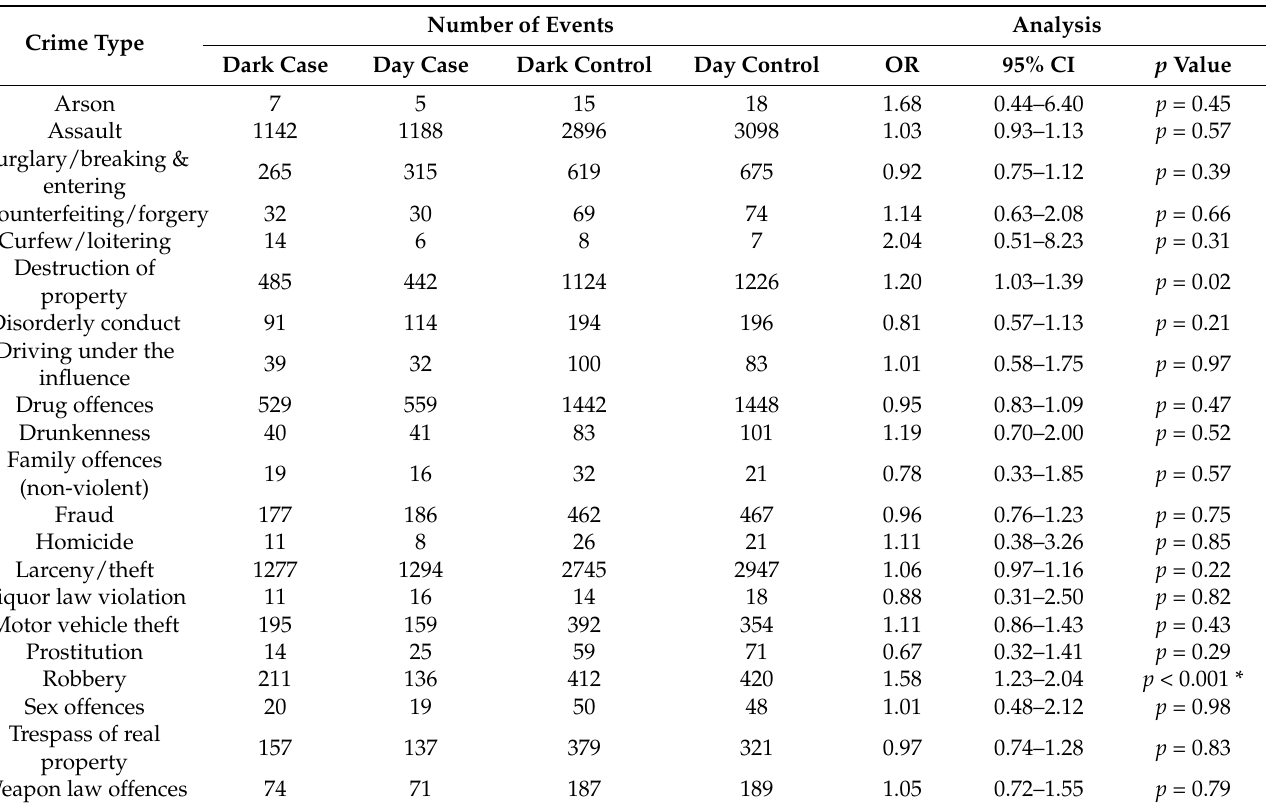
Table 6. ORs and 95% CIs associated with the change in risk at dark compared to daylight according to type of crime. These data are for three US cities-Austin, Chicago and Louisville. The associated p -values indicate whether the OR is significantly different to